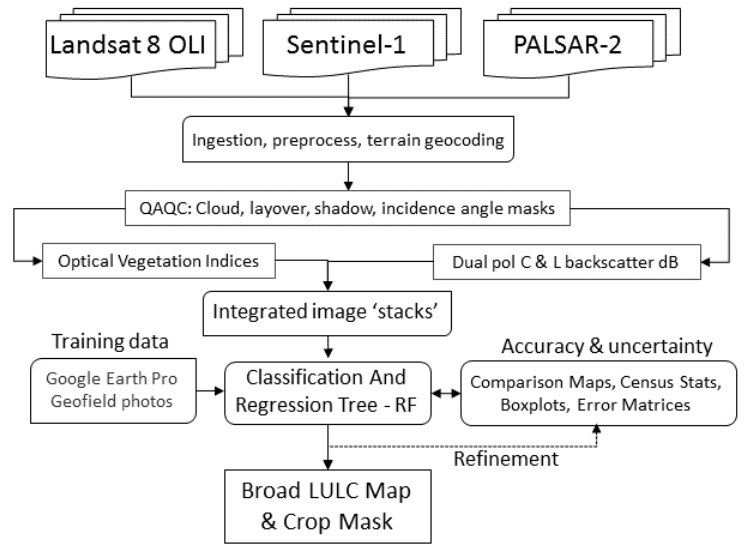
Figure 3. Work flow of multiscale mapping for broad updated land cover land use map.